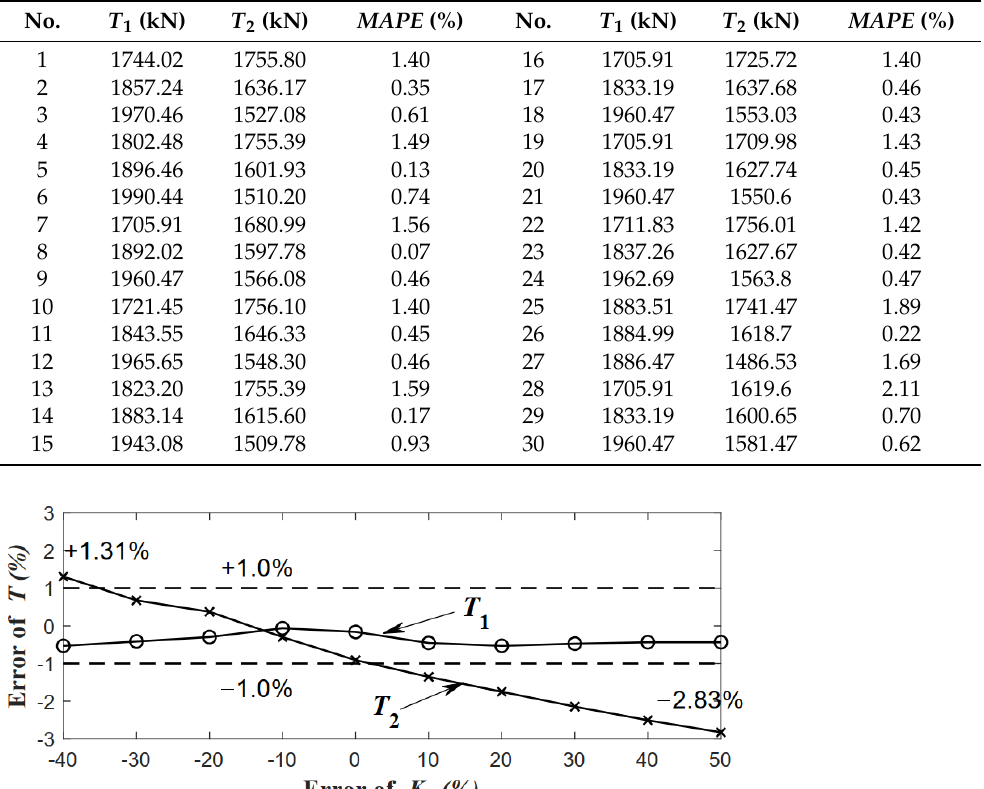
Table 10. MAPE of thirty satisfied combinations.